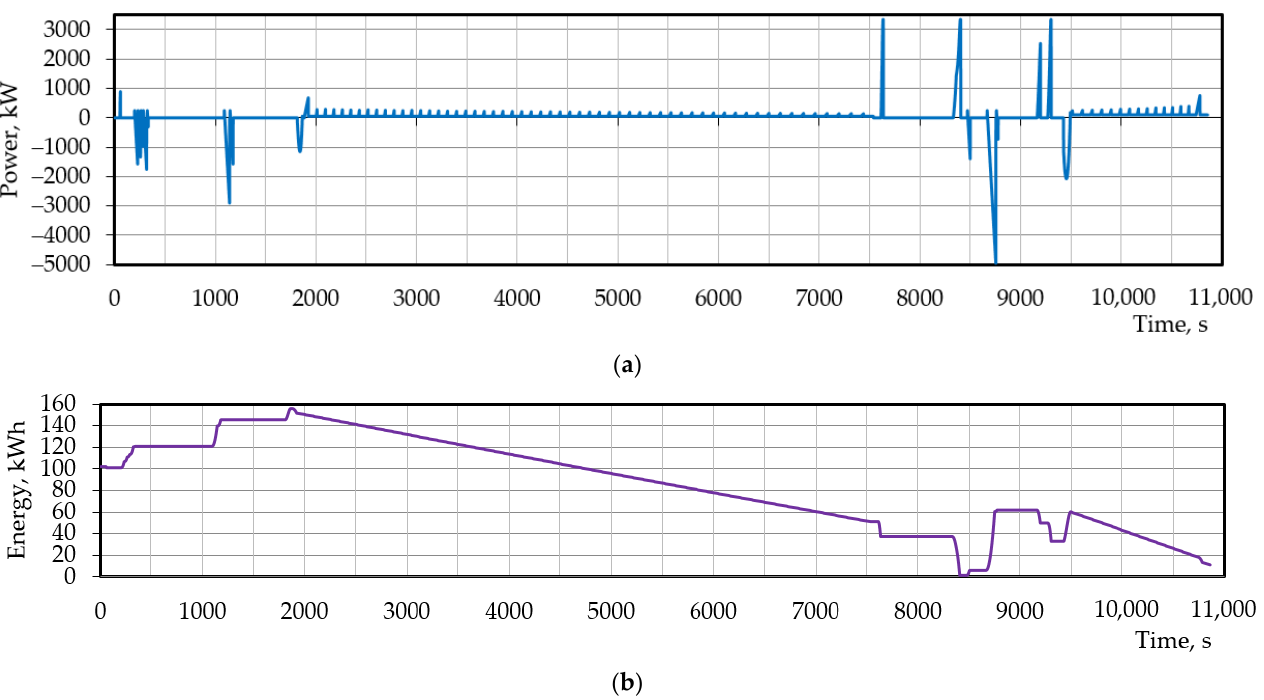
Figure 5. Dependencies of the power exchanged by the on-board ESS with the intermediate circuit ( a ) and energy of the ES ( b ). ( a ) and energy of the ES ( b